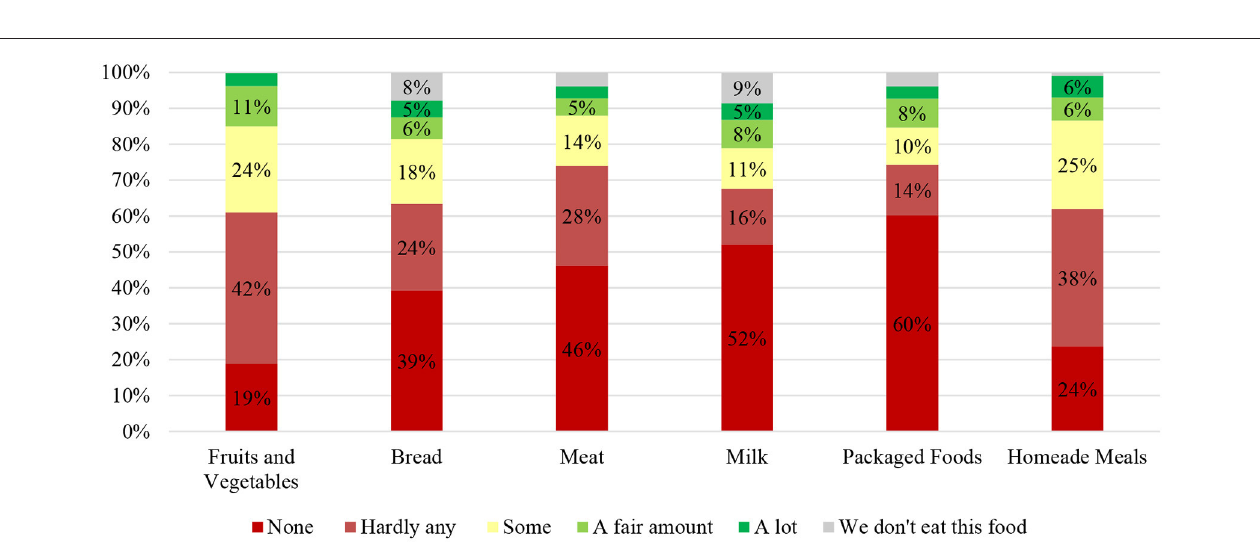
FIGURE 2 | Food waste in the household by food type. Self-reporting of how often food is wasted in the household based on the following food groups: Fruits and vegetables, bread, meat, milk, packaged foods, and homemade meals (values < 5% not labeled in figure).